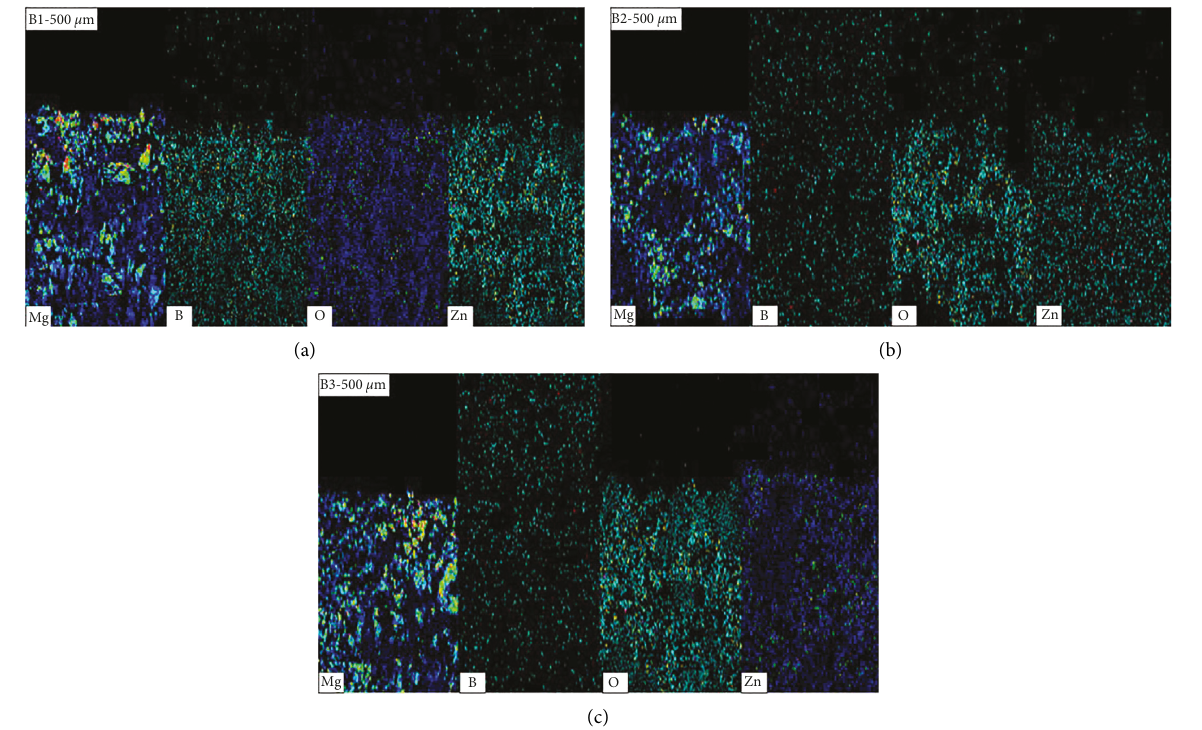
Figure 15: Microstructure analysis of coating B by EPMA. (a) B1. (b) B2. (c) B3.